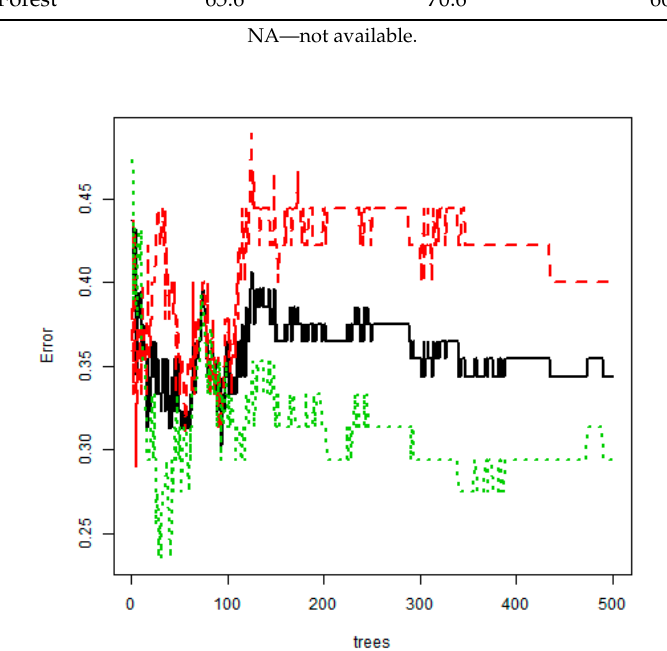
Figure 5. Out-of-bag error rate curve (random forest model). Black line—overall accuracy; red line—sensitivity; Green line—specificity.